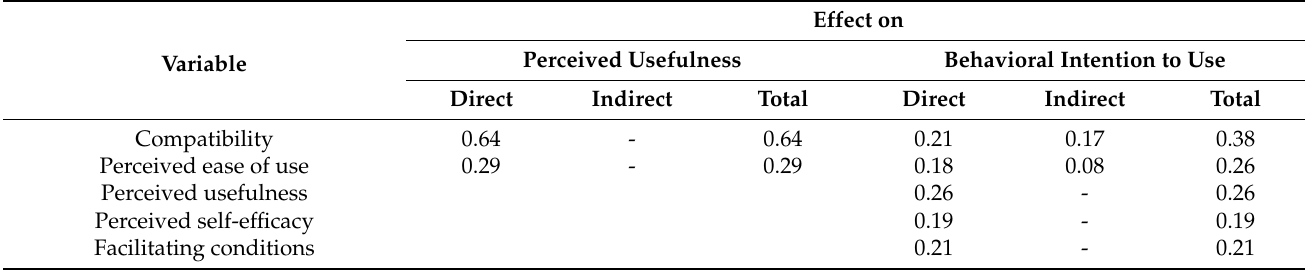
Table 6. Variables’ direct, indirect, and total effects on dependent